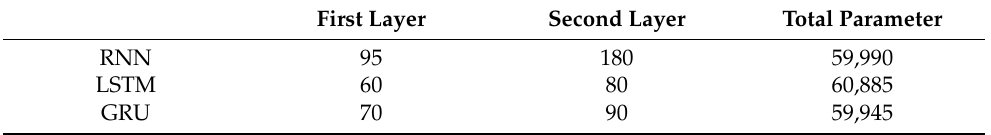
Table 2. Dimensions of each model. The specific meaning of First layer is the number of neurons in the first layer. The specific meaning of Second layer is the number of neurons in the second layer. First Layer Second Layer Total Parameter RNN